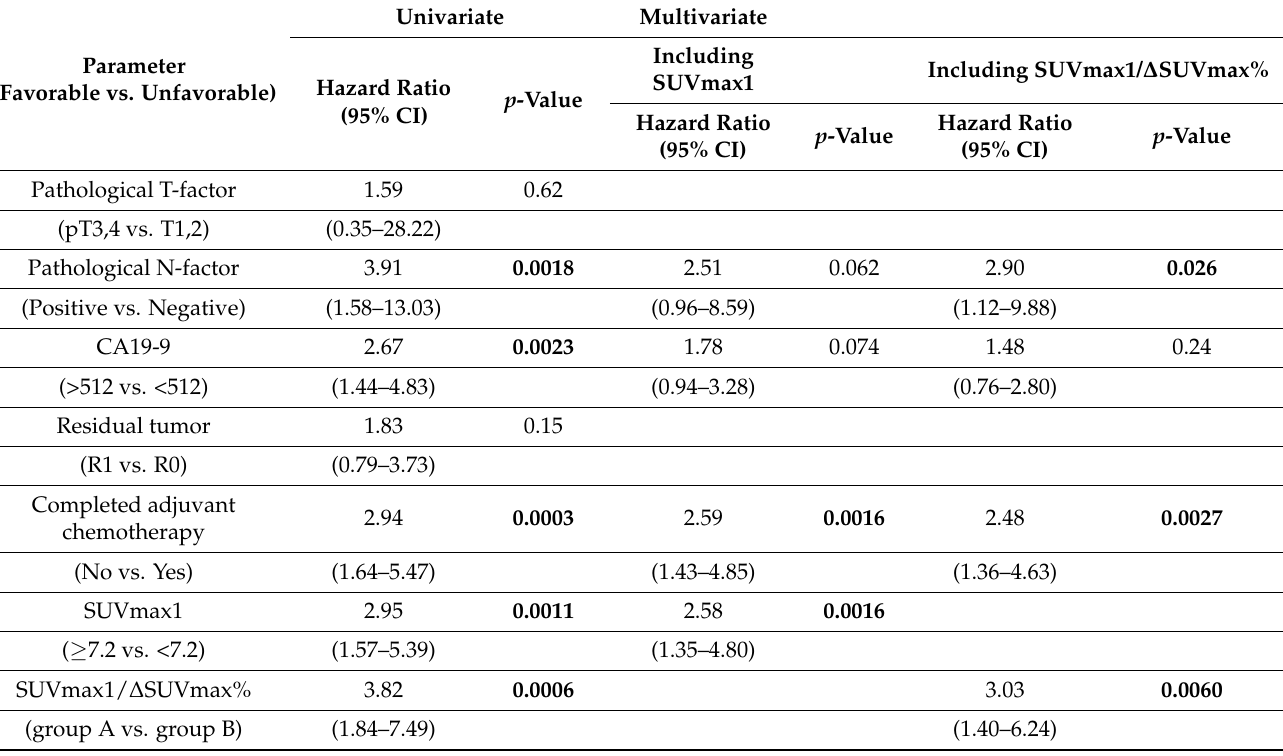
Table 4. Univariate and multivariate analyses of relapse in patients with pancreatic